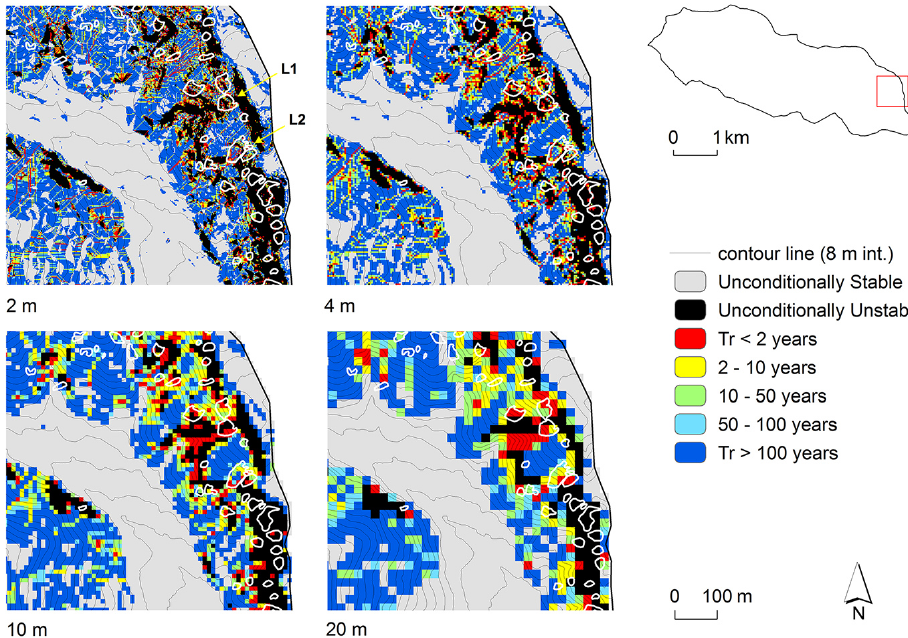
Figure 6. Return period of critical rainfall for four different DTM resolutions: 2, 4, 10, and 20m (detail of the steep valley above the village of Giampilieri). The landslides are surrounded by